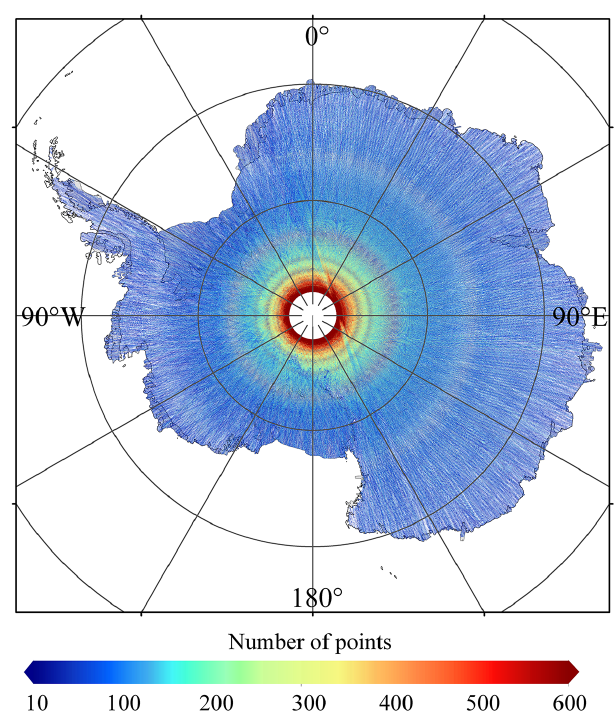
Figure 2. Map of the numbers of valid ICESat-2 measurement points in each 500m grid cell. The numbers of ICESat-2 measure- ment points in 1km grid cells are resampled to the resolution of